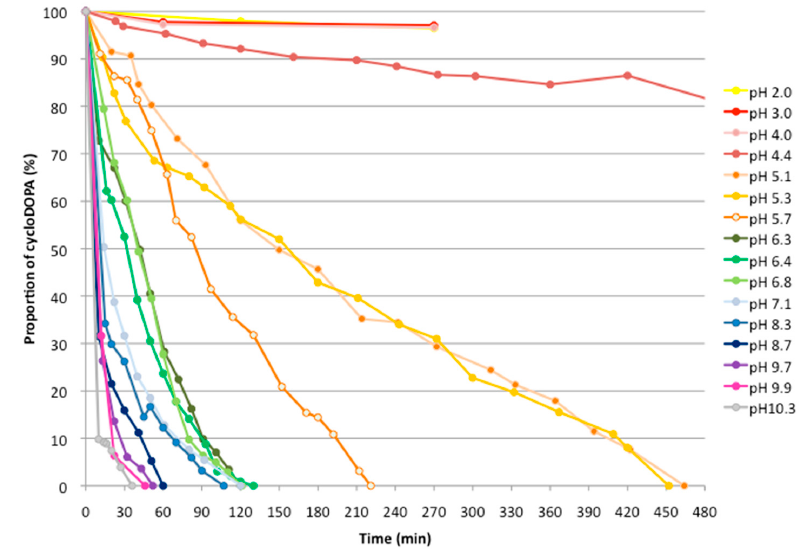
Figure 2. pH stability of cycloDOPA ( 8 ) in D 2 O solution. Solutions of CycloDOPA (4 mg) in D 2 O (0.5 mL, 34 mM, pH < 2) were adjusted to pH levels ranging from 2 to 10 using 1 M NaOD/D 2 O. The resulting samples were analyzed, and the decreases in the α - and β - protons of cycloDOPA were calculated.